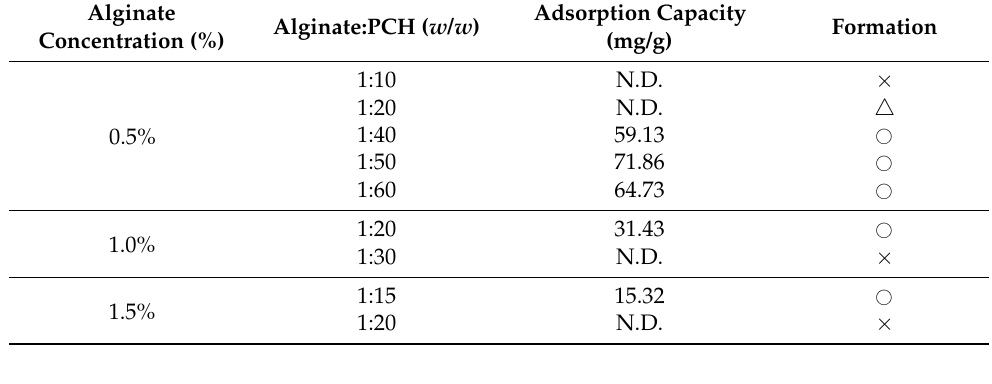
Table 2. Detailed information of optimization of Alg-PCH with toluene adsorption capacity.